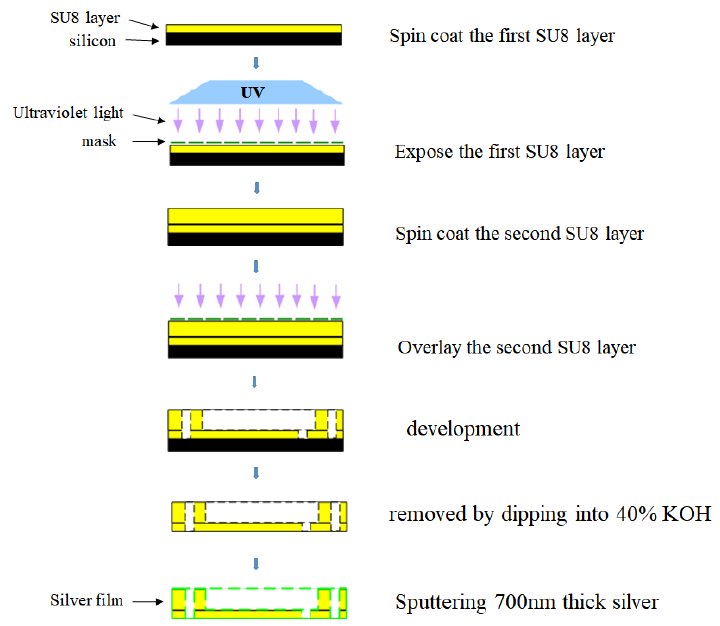
Figure 4. Schematic diagram of SU-8 micromachining process.